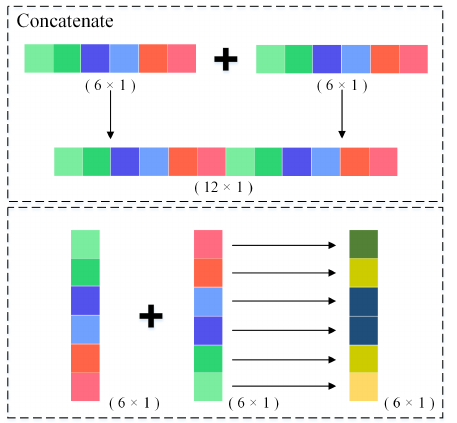
Figure 7. The principles of feature